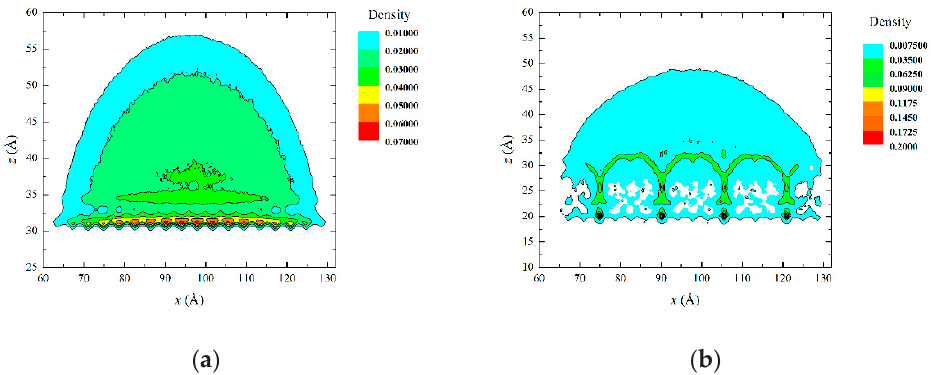
Figure 5. Density profile of a water droplet: ( a ) initial model and ( b ) model after simulation.